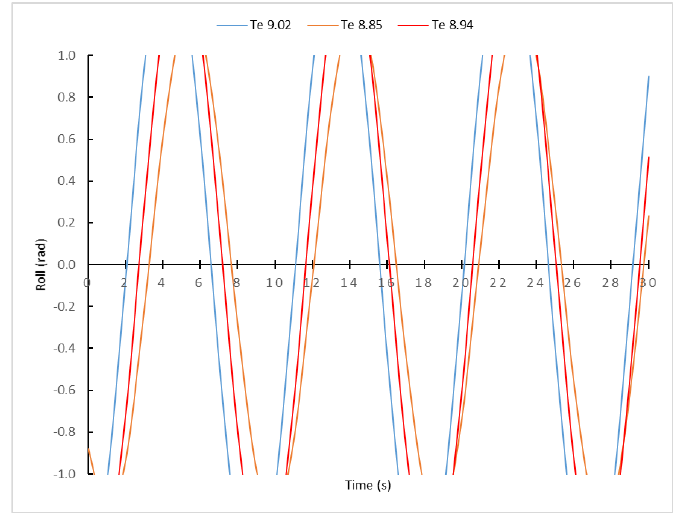
Figure 4. Rolling motion sailing at 8.0 knots and induced by waves with resistance (Tw = 7.1 s; Tw = 7.15 s and Tw = 7.2 s) with an α angle of 45°.